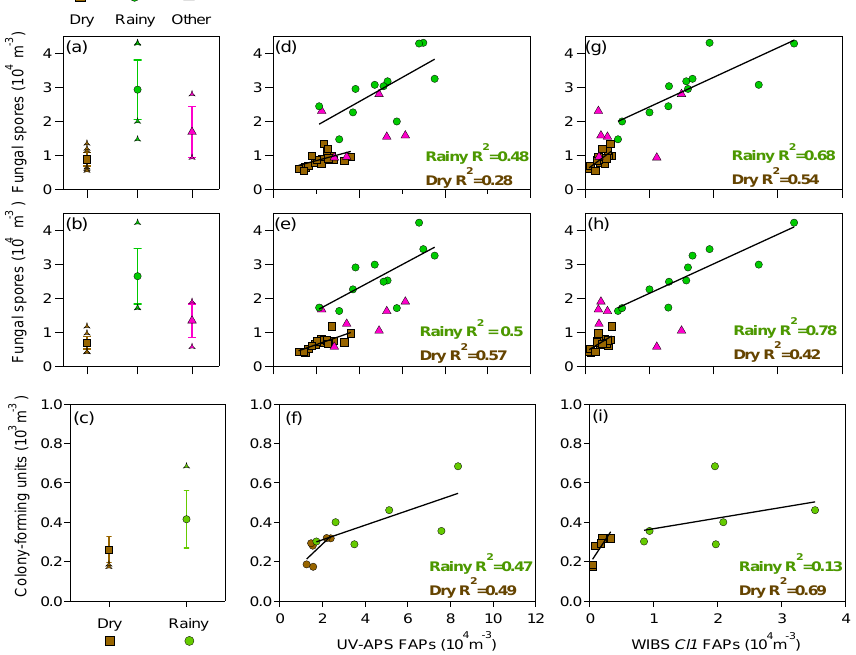
Figure 6. Estimated fungal spore number concentration, calculated using mass of arabitol and mannitol per spore reported by Bauer et al. (2008a). Estimates from arabitol (top row) and mannitol (bottom row). Average fungal spore concentration, calculated using arabitol mass (a) , mannitol mass (b) , and colony-forming units (c) in each wetness category. Central marker shows mean value of individual filter concentration values, bars represent standard deviation (SD) range of filter values, and individual points show outliers beyond mean ± SD. Correlation of fungal spore number calculated from arabitol (d) , mannitol (e) , and colony-forming units (f) concentrations with estimated fluorescent particle mass from UV-APS. Correlation of fungal spore number calculated from arabitol (g) , mannitol (h) , and colony-forming unit (i) concentrations with fluorescent particle concentrations from WIBS cluster 1. R 2 value shown for each fit (right two columns). Linear fit parameters are shown in Table